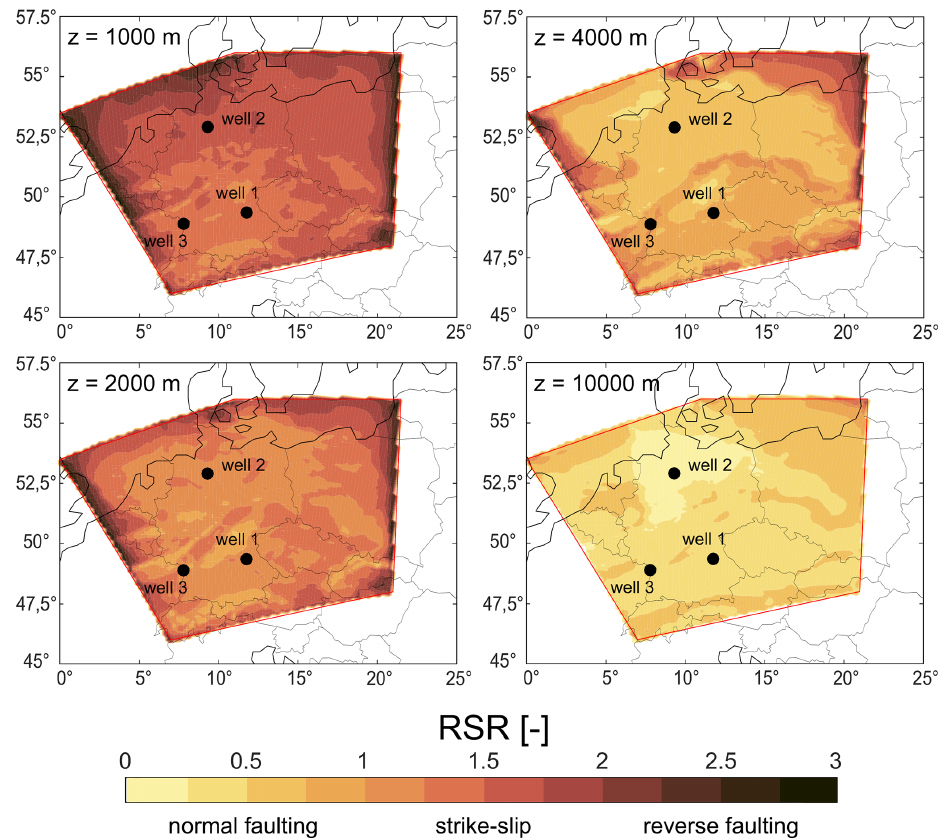
Figure 11. RSR indicating the stress regime for four model sections for different depths. The three black dots show the locations of the three hypothetical wells in Fig. 10. The high RSR values at the model edges in the upper 4000m, representing a constriction, are edge effects due to the applied boundary conditions. We used a color map based on “lajolla” of Crameri (2021).Coastlines and borders used in the figures are based on the Global Self-consistent Hierarchical High-resolution Geography (GSHHG) of Wessel and Smith